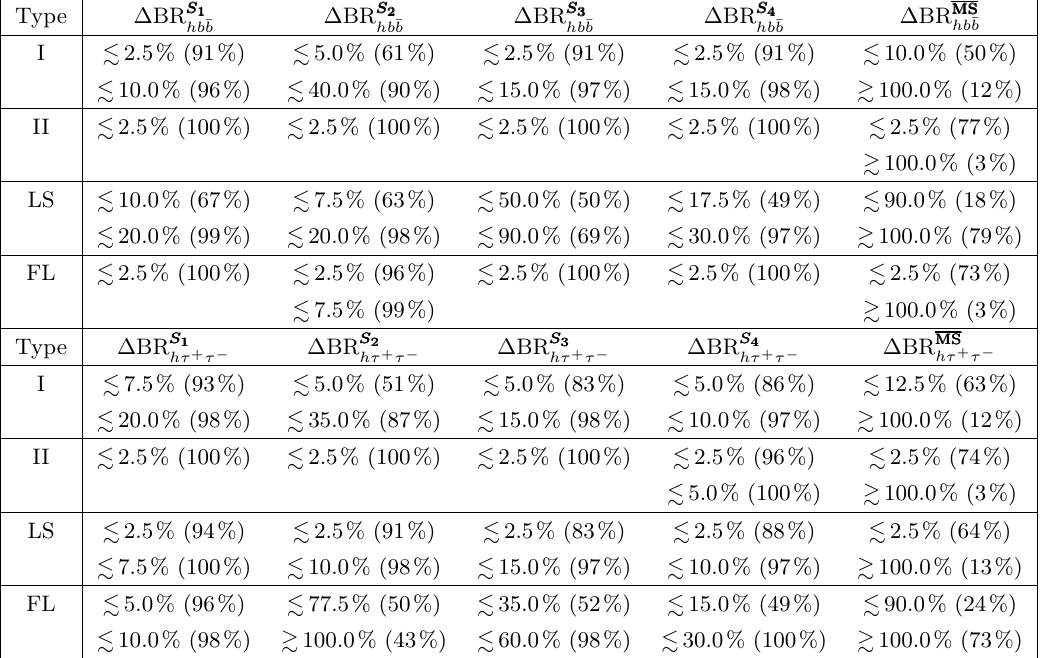
Table 11 . Relative size of the EW corrections to the BRs for the non-SM-like 2HDM Higgs boson h decays into b (cid:22) b and (cid:28) + (cid:28) (cid:0) , in the four 2HDM types I, II, LS and FL ( H is SM-like).